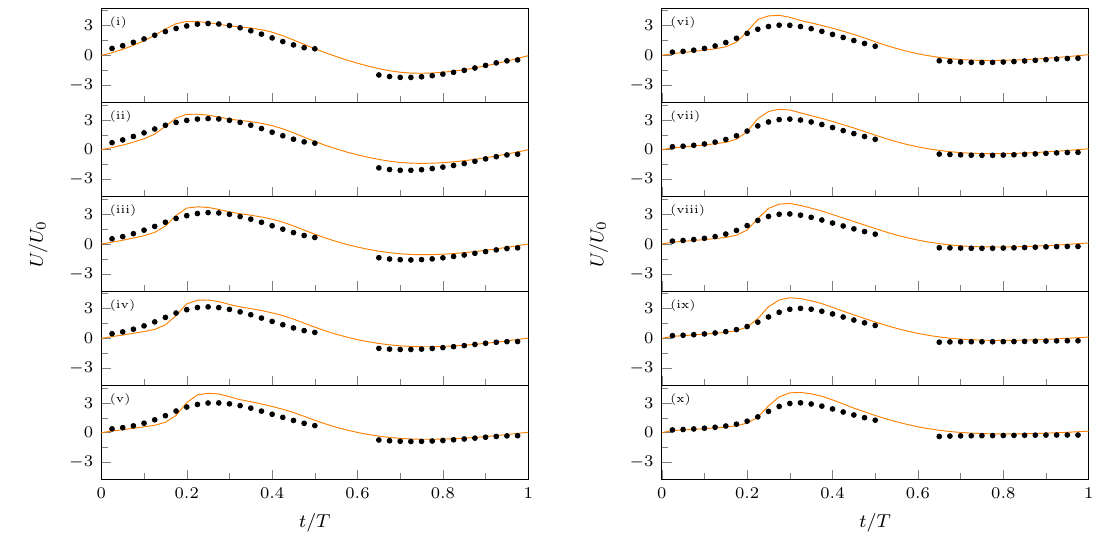
Figure 6. Phase-averaged streamwise velocity profiles along the centreline, at increasing distances from the slot exit. Slot 2, (i) x / h = 0.2, (ii) x / h = 0.4, (iii) x / h = 0.6, (iv) x / h = 0.8, (v) x / h = 1.0, (vi) x / h = 1.2, (vii) x / h = 1.4, (viii) x / h = 1.6, (ix) x / h = 1.8, (x) x / h = 2.0; numerical (solid line), experimental ( • ).